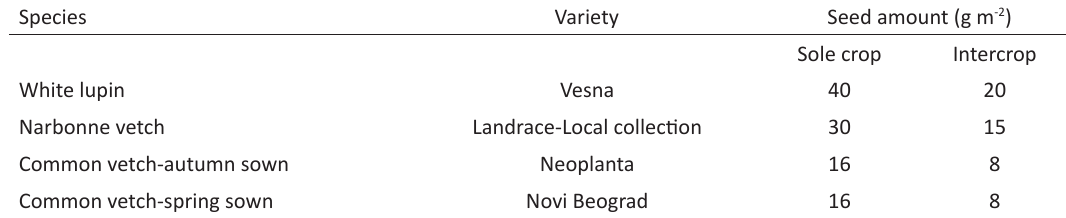
Table 2. Species, varieties and seed amount used in the experiment